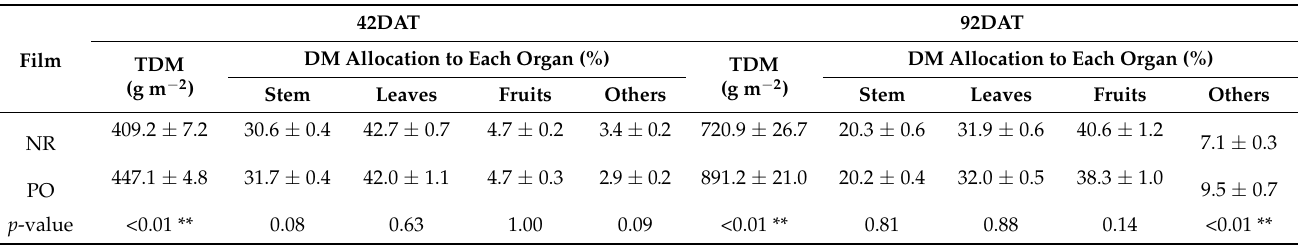
Table 2. Effects of high tunnel-covering film on total dry matter (TDM) and dry matter (DM) allocation to each organ at 42 and 92 DAT.